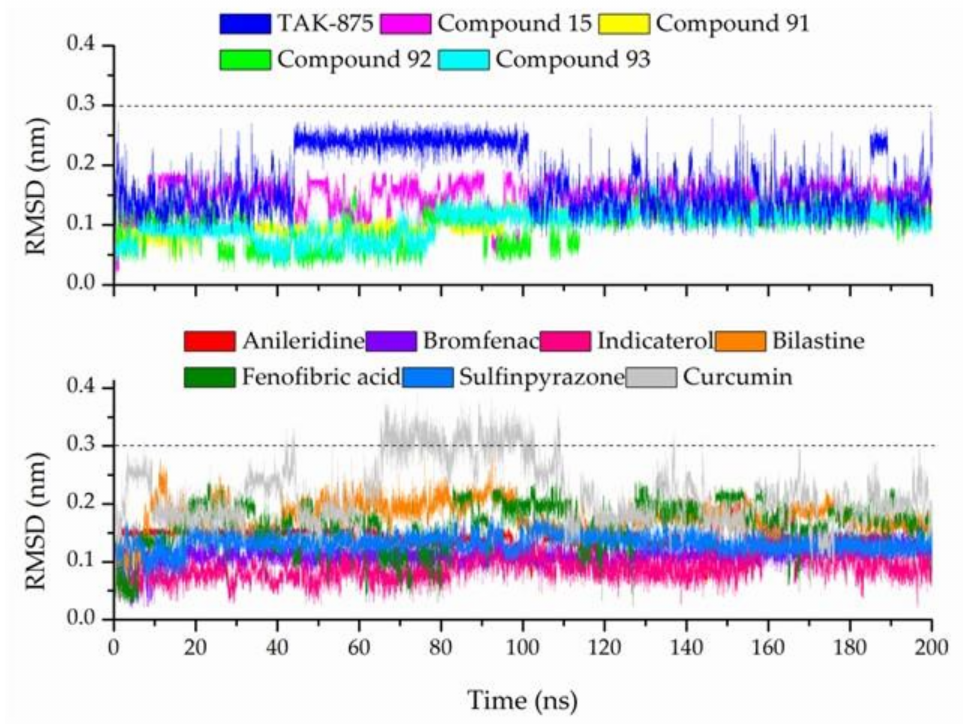
Figure 8. RMSD of the ligands of the dataset ( top ) and the screening ( bottom ) during the 200 ns MD